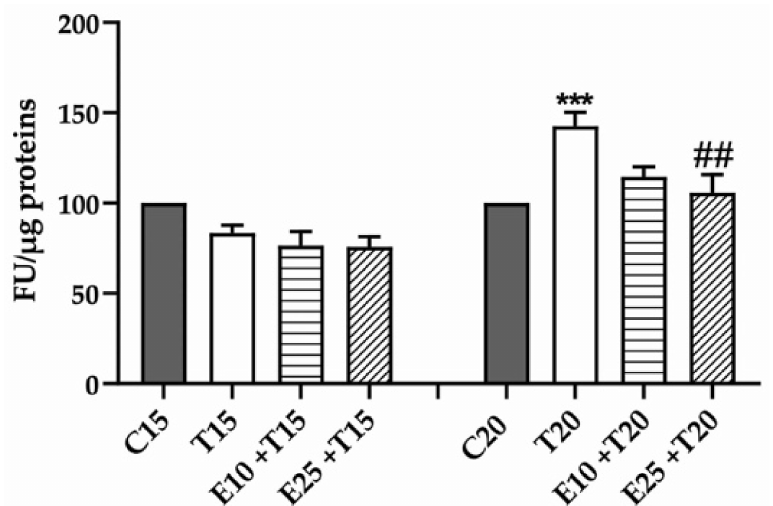
Figure 1. ROS production, expressed as Fluorescence Units on protein content ( µ g), after mERC and UV-A treatment. HMEC-1 were treated for 1 h with 10 or 25 µ g / mL of mERC (E10, E25) and exposed to 15 or 20 J / cm 2 UV-A (T15, T20). Results are expressed as mean ± SEM, n = 5. Statistical analysis: One-Way ANOVA with Bonferroni’s post hoc analysis. *** p < 0.001 vs. C20, ## p < 0.05 vs.